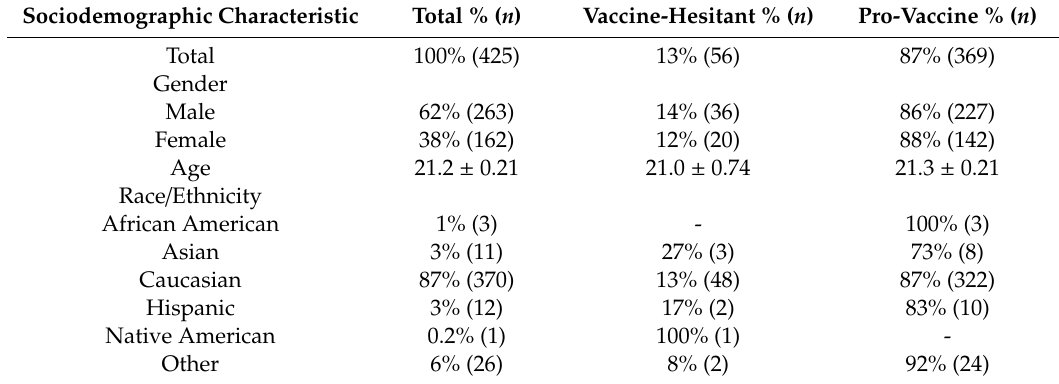
Table 2. Baseline characteristics of vaccine-hesitant and pro-vaccine groups ( n =